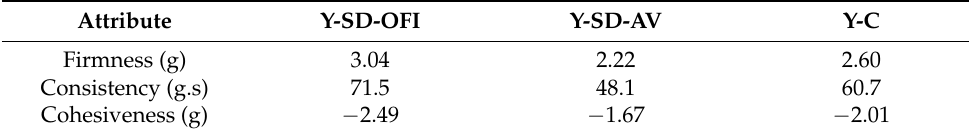
Table 3. Texture profile data of Y-SD-OFI, Y-SD-AV, and Y-C yogurt models.